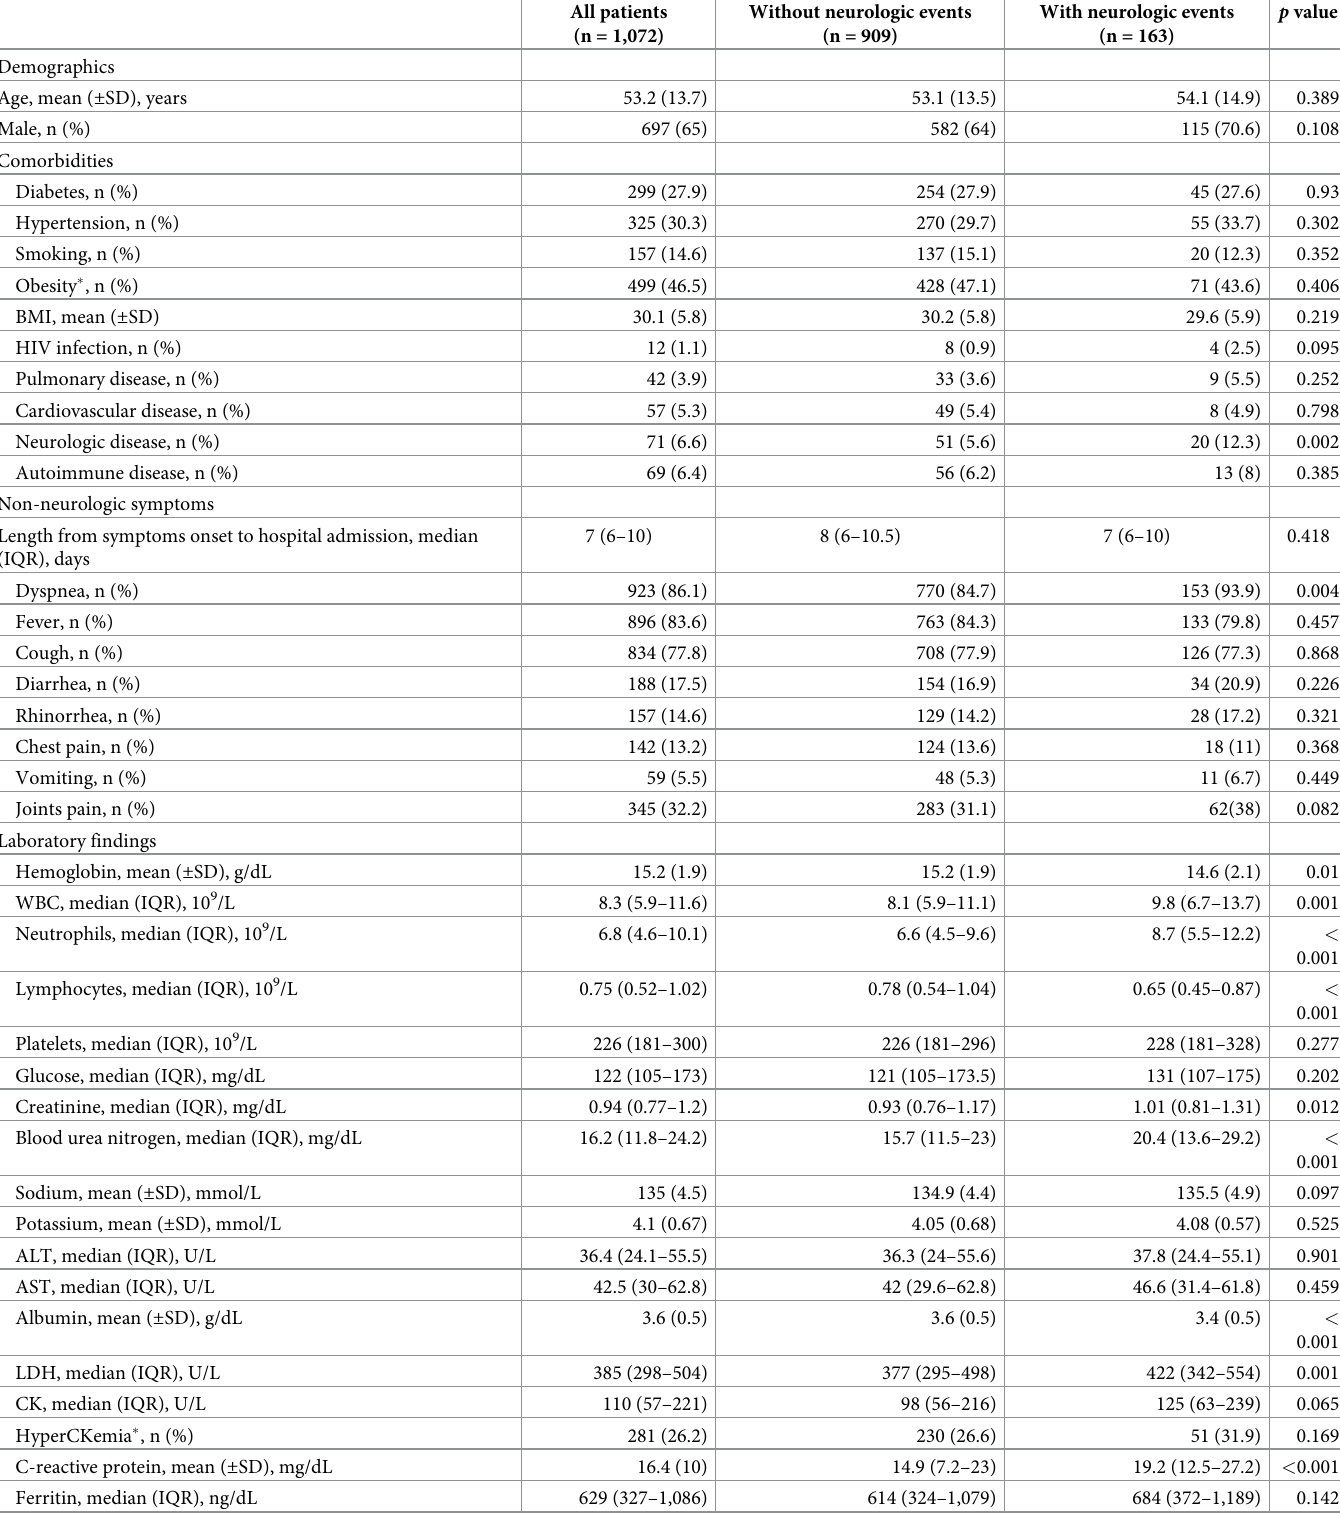
Table 1. Characteristics of the patients hospitalized with moderate to severe